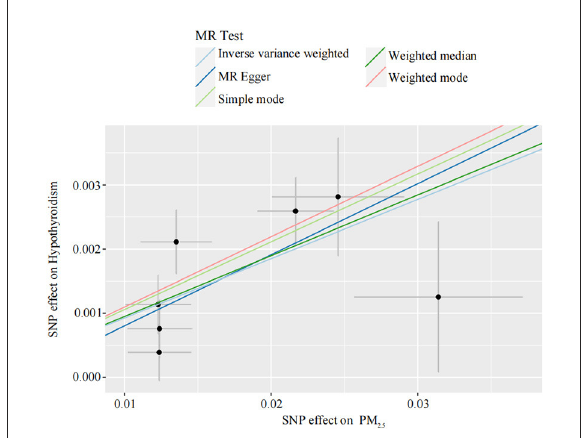
FIGURE2 Individual estimates about the putative causal effect of PM 2.5 on hypothyroidism. The x-axis shows the SNP effect and SE on each PM 2.5 . The y-axis shows the SNP effect and SE on hypothyroidism. The regression line for MR Egger, weighted median, inverse variance weighted, simple mode, and weighted mode is shown. PM 2.5 , particulate matter 2.5; SNP, single nucleotide polymorphism; SE, standard